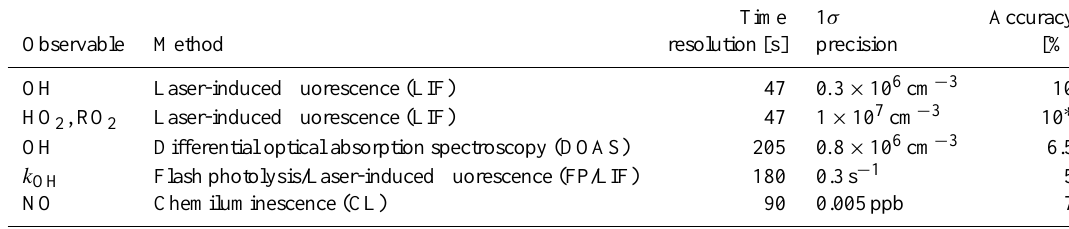
Table 1. Properties of key instruments for the investigation of OH budgets during SAPHIR